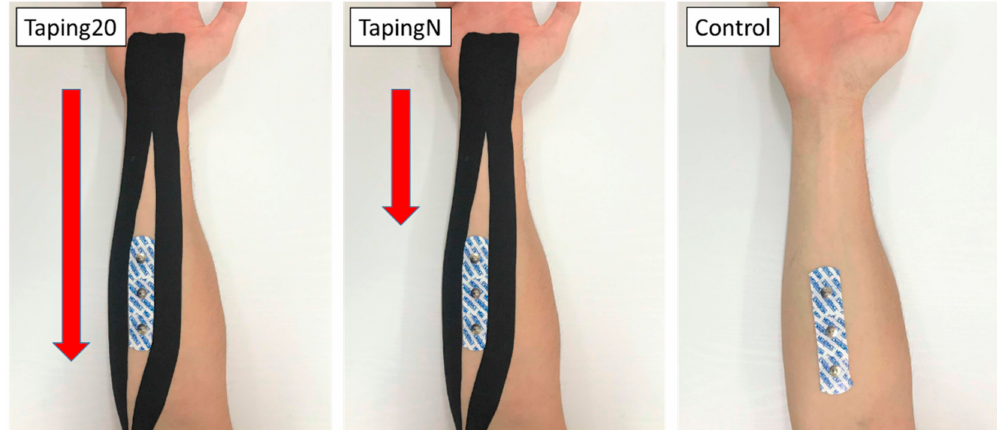
Figure 1. The 3 Kinesio taping conditions. From left to right: (1) taping with 20% additional tension (taping20), (2) taping with neutral tension (tapingN), and (3) without taping